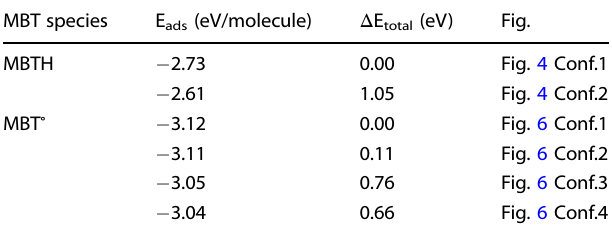
Table 1. Adsorption energy (E ads in eV/molecule) and total energy difference ( Δ E total in eV) of MBT for the thione (MBTH) and thiolate (MBT°) species adsorbed on the partially oxide-covered copper surface (Cu(111) ∣∣ Cu 2 O(111)-hole system). The adsorption energy is calculated using equation (1) for MBTH and MBT°